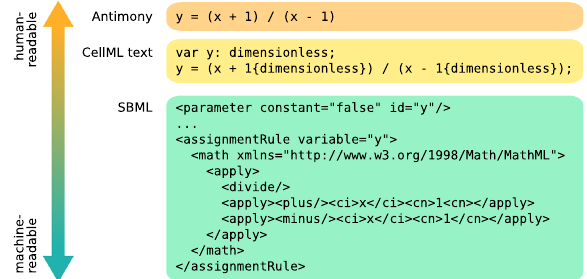
Fig. 1 Simple variable de fi nition with assignment rule in three modeling languages with different levels of focus on human- versus machine-readability. Each of the three code snippets contains the same information de fi ning a variable y, which depends on another preexisting variable x. Antimony mainly focuses on how humans would write equations in text form, but requires a specialized parser. CellML Text — an intermediary editing language used by the tool OpenCOR 69 — adds some syntax that is easy to parse by a machine (due to using braces that do not con fl ict with other symbols in the code), but is not an intuitive representation of unit information for a human unfamiliar with the language. SBML focuses more on machine-readability, since XML can be parsed by the standard libraries of most modern programming languages, ensuring minimal barriers for tool support. However, while the SBML code is still readable and editable in a text editor, it takes some effort and familiarity with the language to decipher the meaning from the